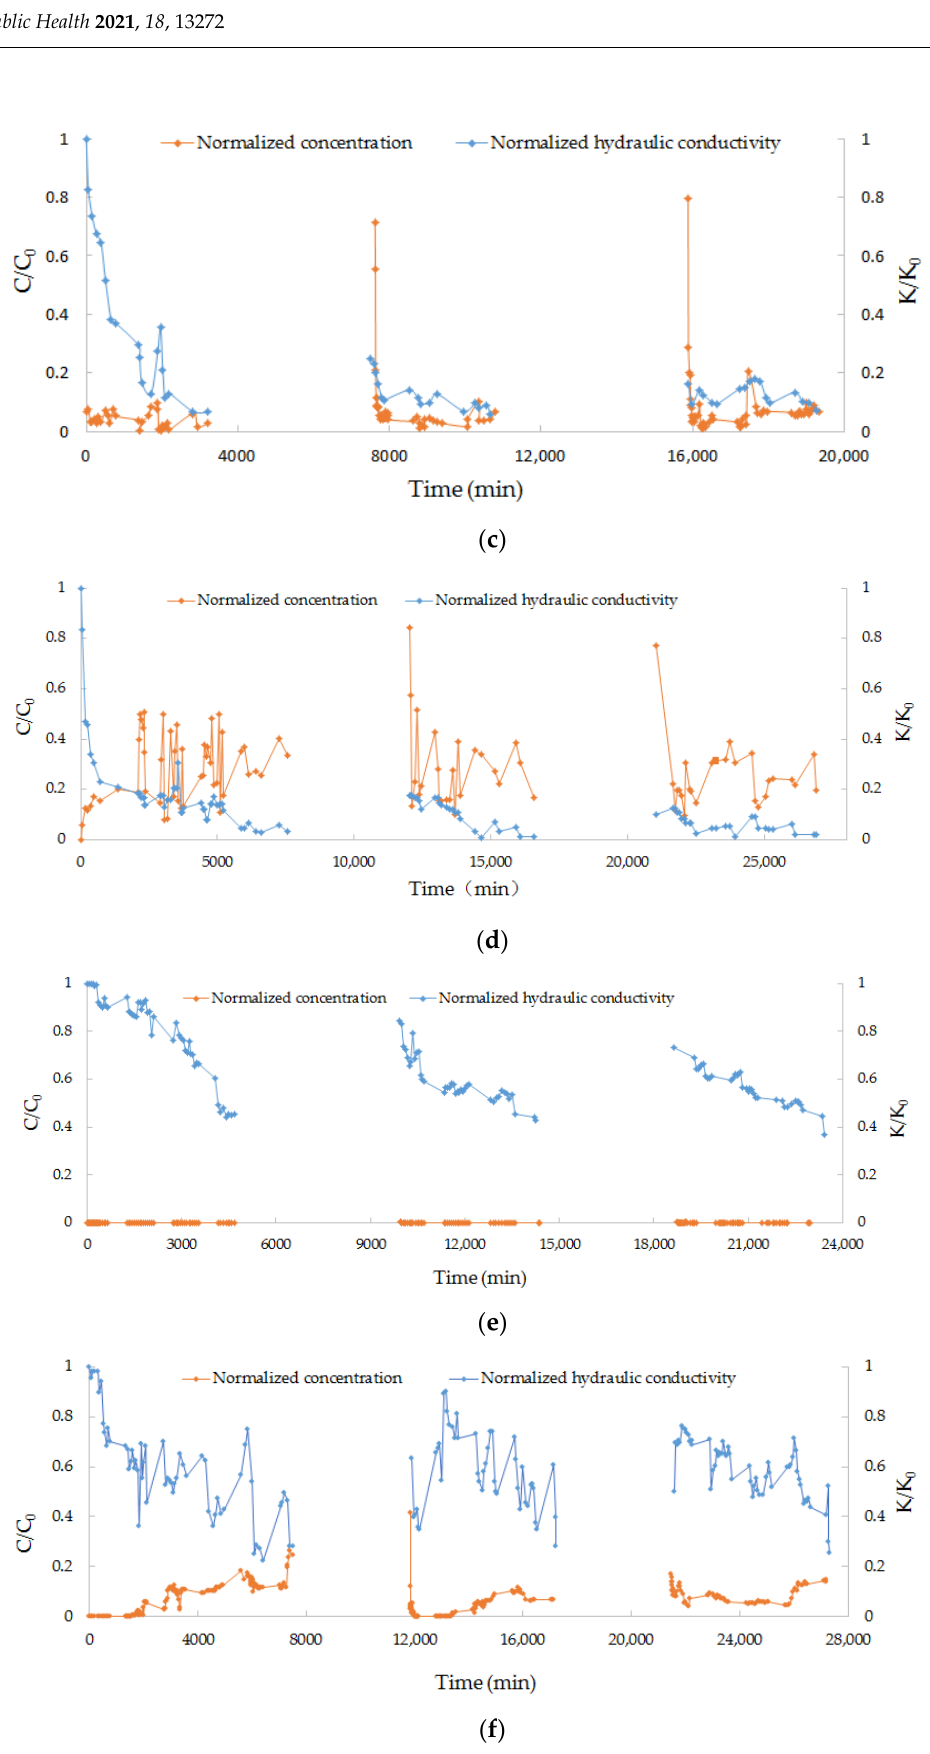
Figure 2. Diagram of K/K0 vs. C/C0. ( a ) E1 (Fe + fine sand); ( b ) E2 (Fe + medium sand); ( c ) E3 (Zn + fine sand); ( d ) E4 (Zn + medium sand); ( e ) E5 (Pb + fine sand); ( f ) E6 (Pb + medium sand).